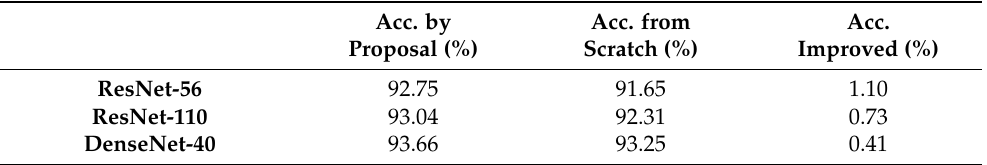
Acc. by Acc. from Acc. Proposal (%) Scratch (%) Improved